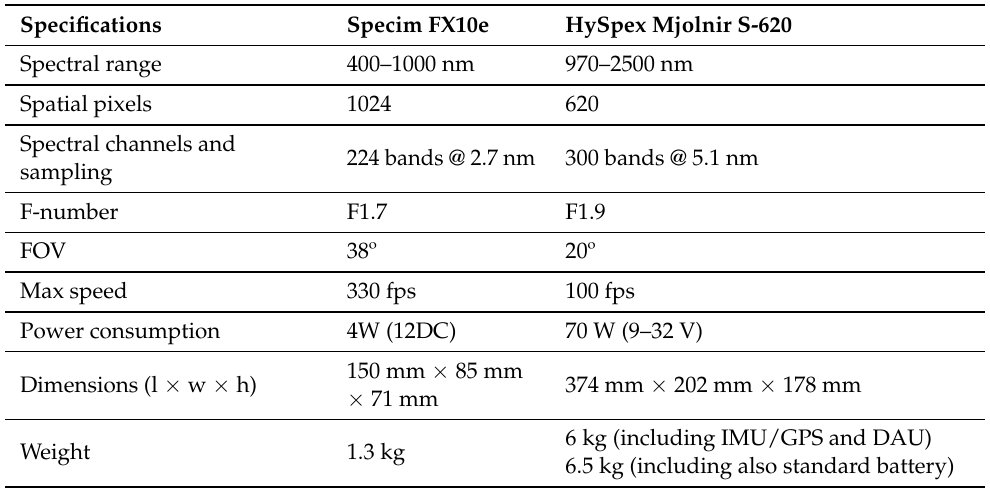
Table 2. Specim FX10e and HySpex Mjolnir S-620 main characteristics.